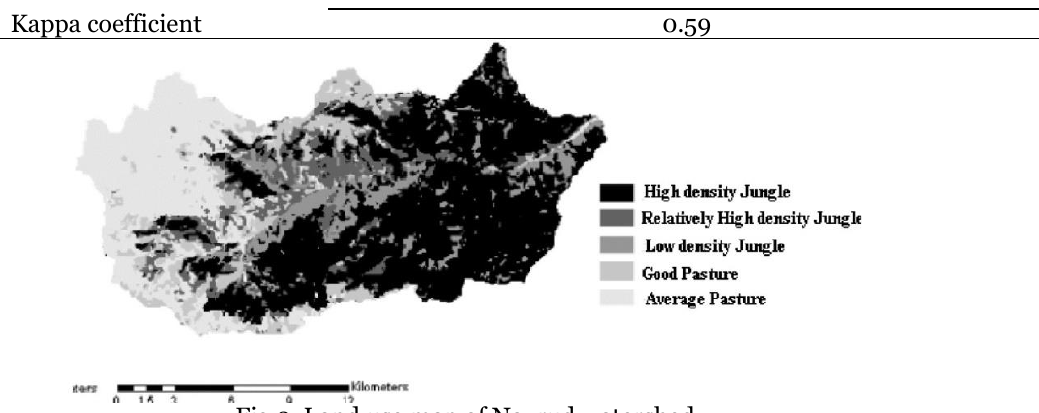
Fig.2. Land use map of Navrud watershed